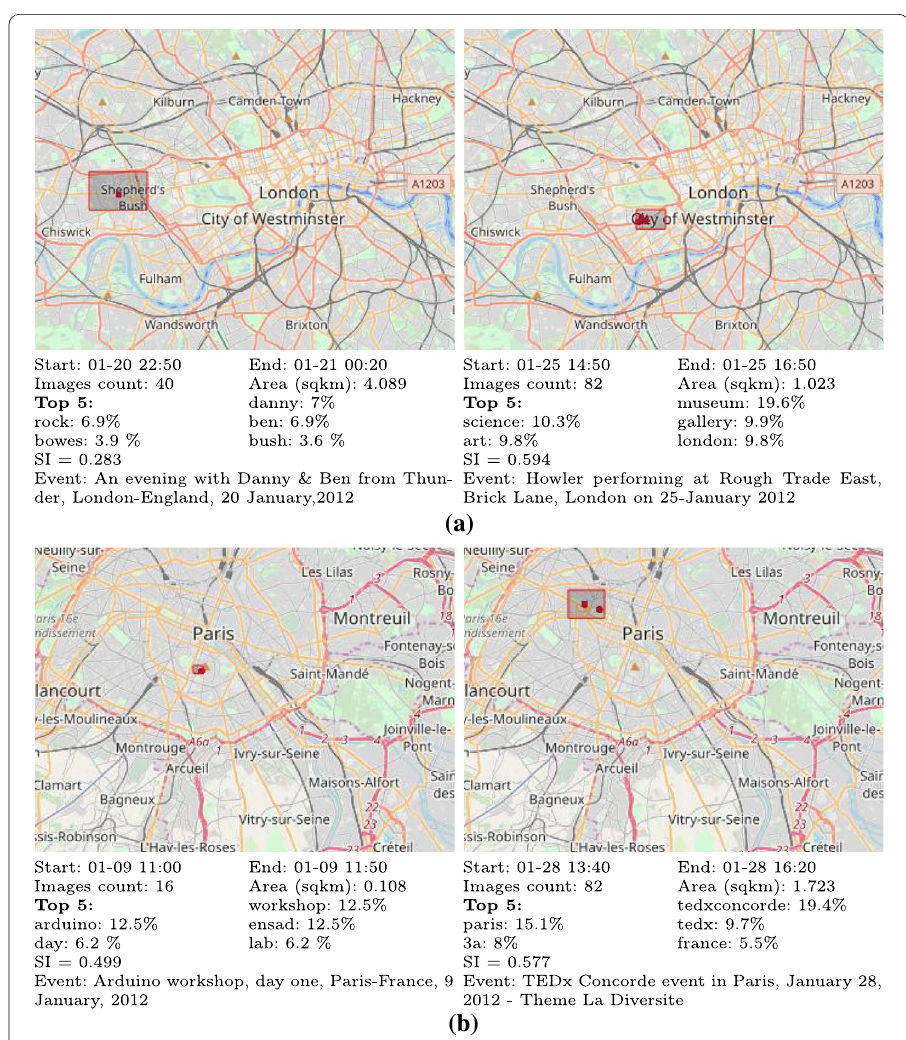
Fig. 4 Sample event detection results using Flickr images, January-2012 in: (a) London, (b)